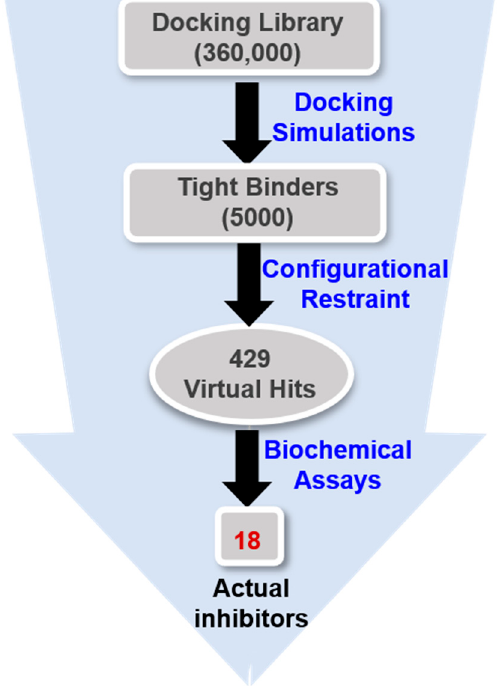
Figure 3. Flowchart for the discovery of new small-molecule inhibitors of the G2019S mutant of LRRK2 through virtual screening and enzyme inhibition assays.